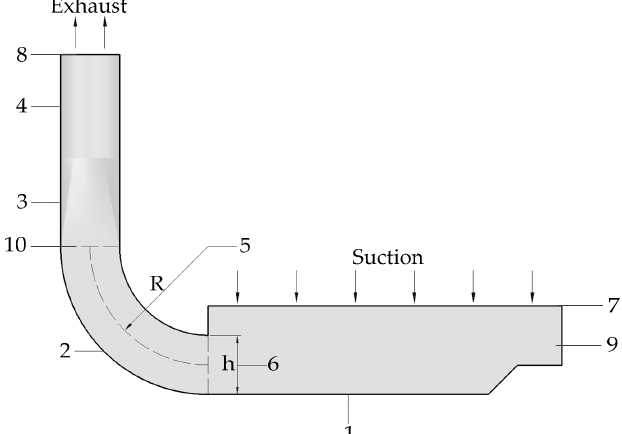
Figure 2. Model components and positional relationship between R and h. 1—Inlet hood;